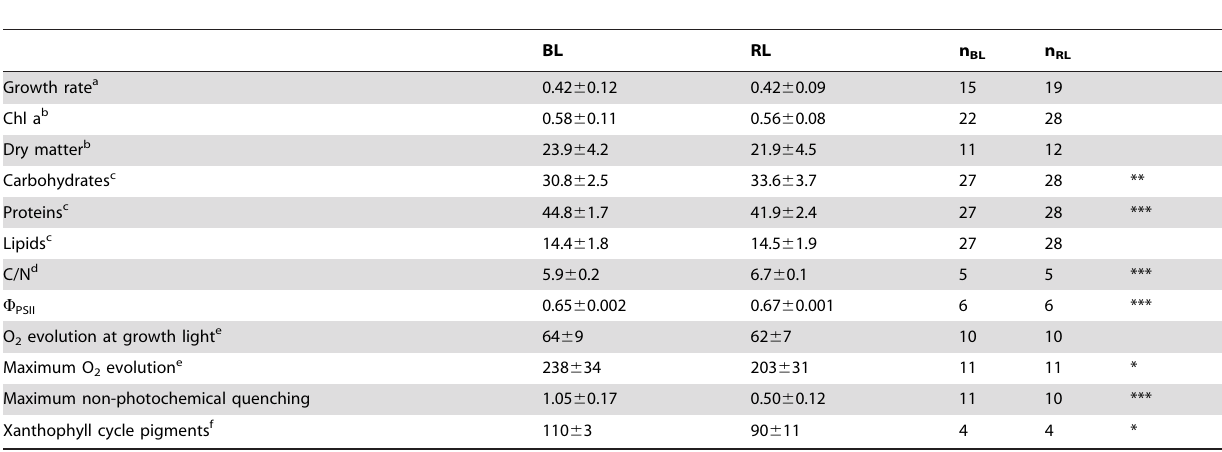
Table 1. Growth rate, photosynthetic parameters and the macromolecular composition of BL and RL light acclimated P. tricornutum